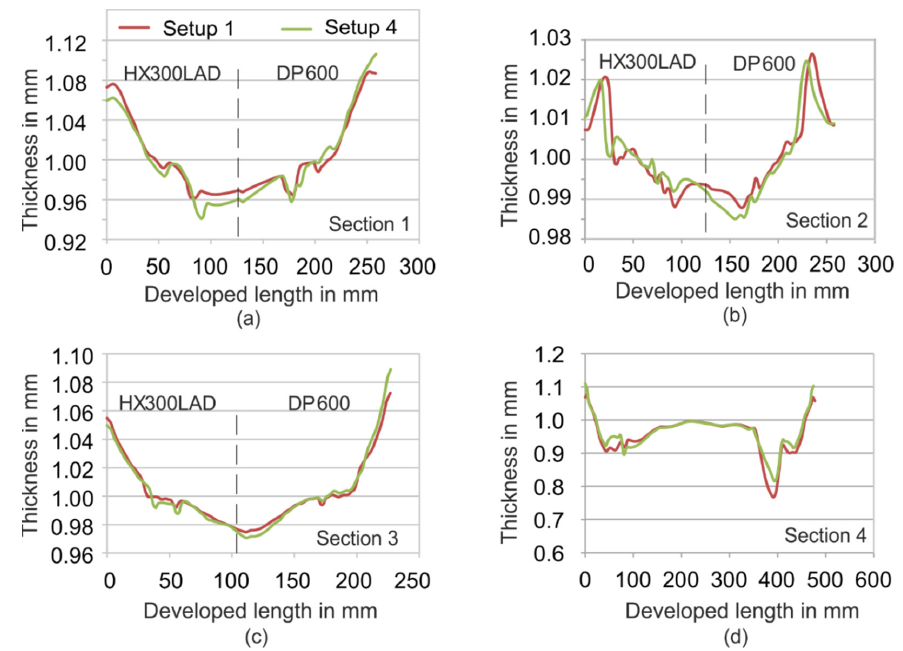
Figure 11. Thickness distribution for Setups 1 (steel/steel) and 4 (steel/polymer K3). ( a ) Section 1; ( b ) Section 2; ( c ) Section 3; ( d ) Section 4.